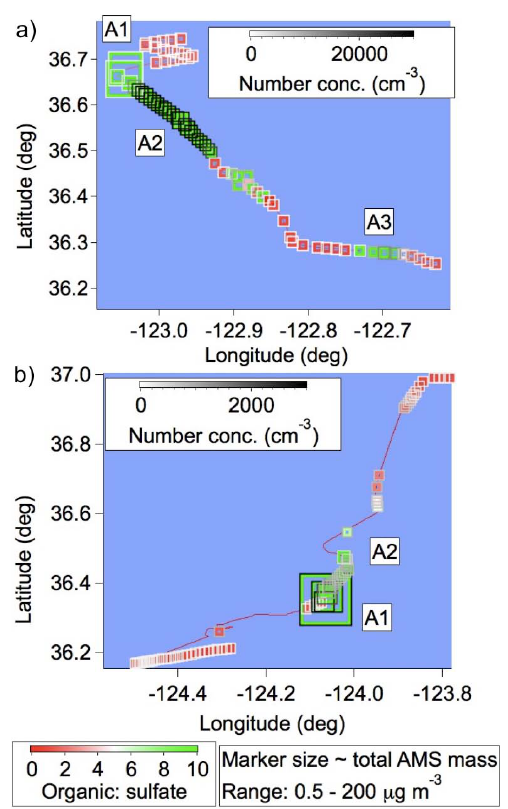
Fig. 4. R/V Point Sur ship trace during plume sampling on 17 July (a) and 18 July (b) . The plume location is identified by values of organic:sulfate >5 (green markers). Black borders indicate high particle number concentrations. A1, A2, and A3 designate the three plume ages described in Sect.